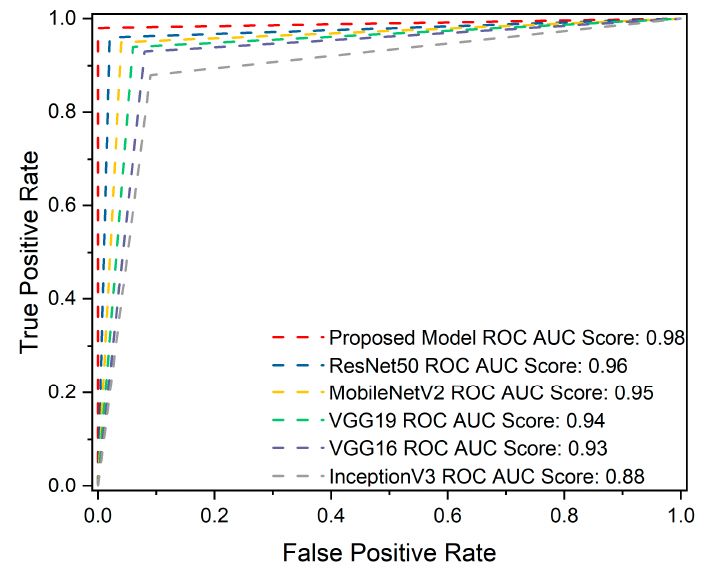
Figure 8. The overall receiver operating characteristic (ROC) area under the curve (AUC) score for the proposed and pre-trained models. The proposed model obtained the highest ROC AUC score of 98%, indicating its superior ability to discriminate between positive and negative classes. In contrast, ResNet50 scored 96% in ROC AUC, MobileNetV2 achieved a score of 95%, VGG19 scored 94%, VGG16 scored 93%, and InceptionV3 achieved 88%. These results demonstrate the superiority of the proposed model over the pre-trained models in terms of ROC AUC scores, underscoring its robustness in differentiating among the brain tumor classes.